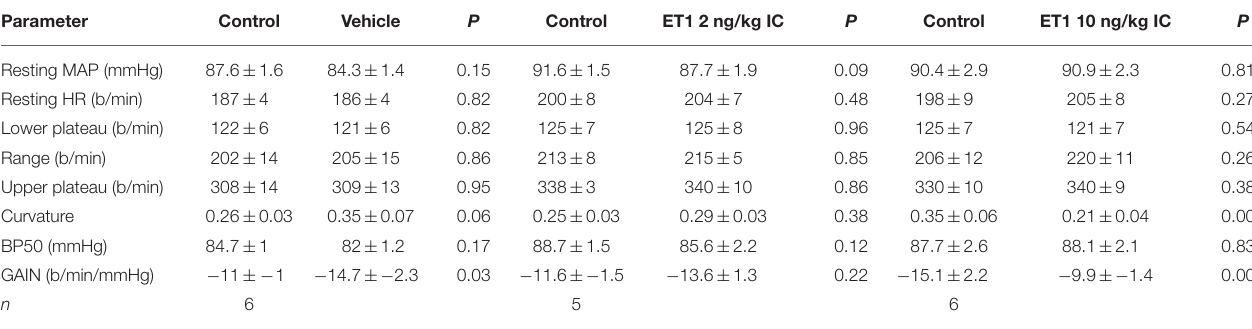
TABLE 2 | Changes in barorflex paramaters before (control) and after administration of vehicle or endothelin − 1.